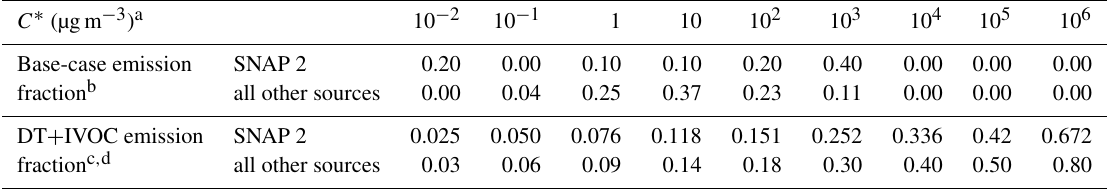
Table 3. Volatility distributions of the primary organic aerosol (POA) emissions from anthropogenic sources. C ∗ (µgm − 3 )